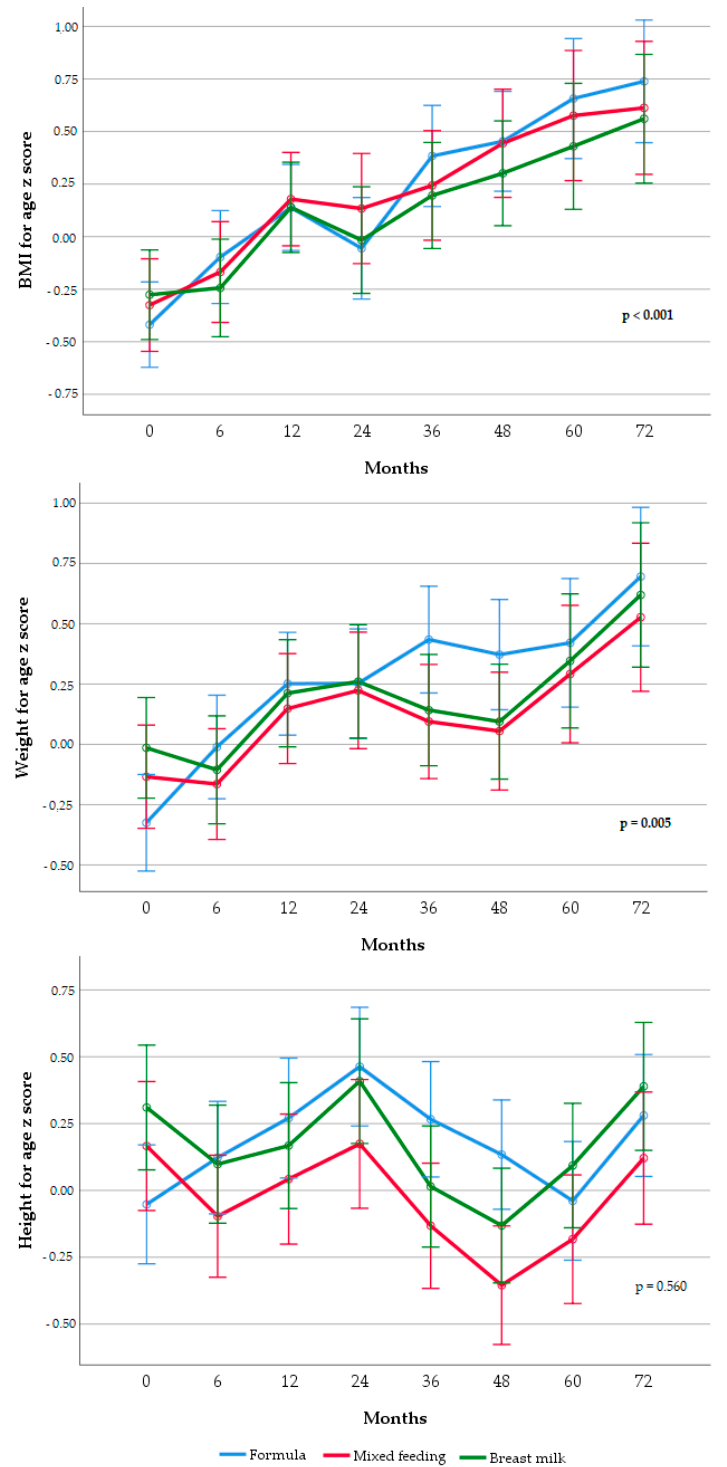
Figure 2. Trajectories of z-scores of infant BMI, weight, and height according to infant feeding practice in the first 120 days of life. Results are displayed as unadjusted estimated mean z-scores +/- 2SE from repeated-measures ANOVA. After adjusting by gestational age at birth, birth weight, maternal education, ethnicity, paternal and maternal BMI, and smoking during pregnancy, significant differences remained in BAz ( p < 0.01) and WAz ( p < 0.01) but not in HAz ( p = 0.33). BMI, body mass index; RWG, rapid weight gain, SE, standard error.